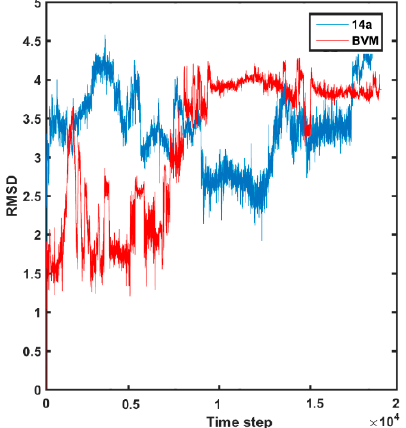
Figure 12. Variations of RMSD values in MDS of molecule 14a and BVM.